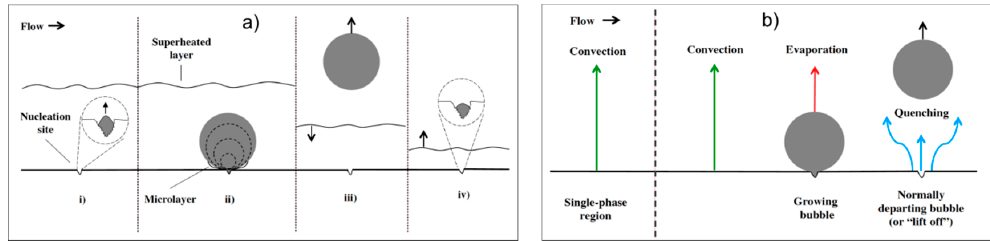
Figure 2. ( a ) Current understanding of the cycle of processes associated with boiling; ( b ) basic representation of the main mechanisms of wall heat transfer. From Thakrar et al. [15].